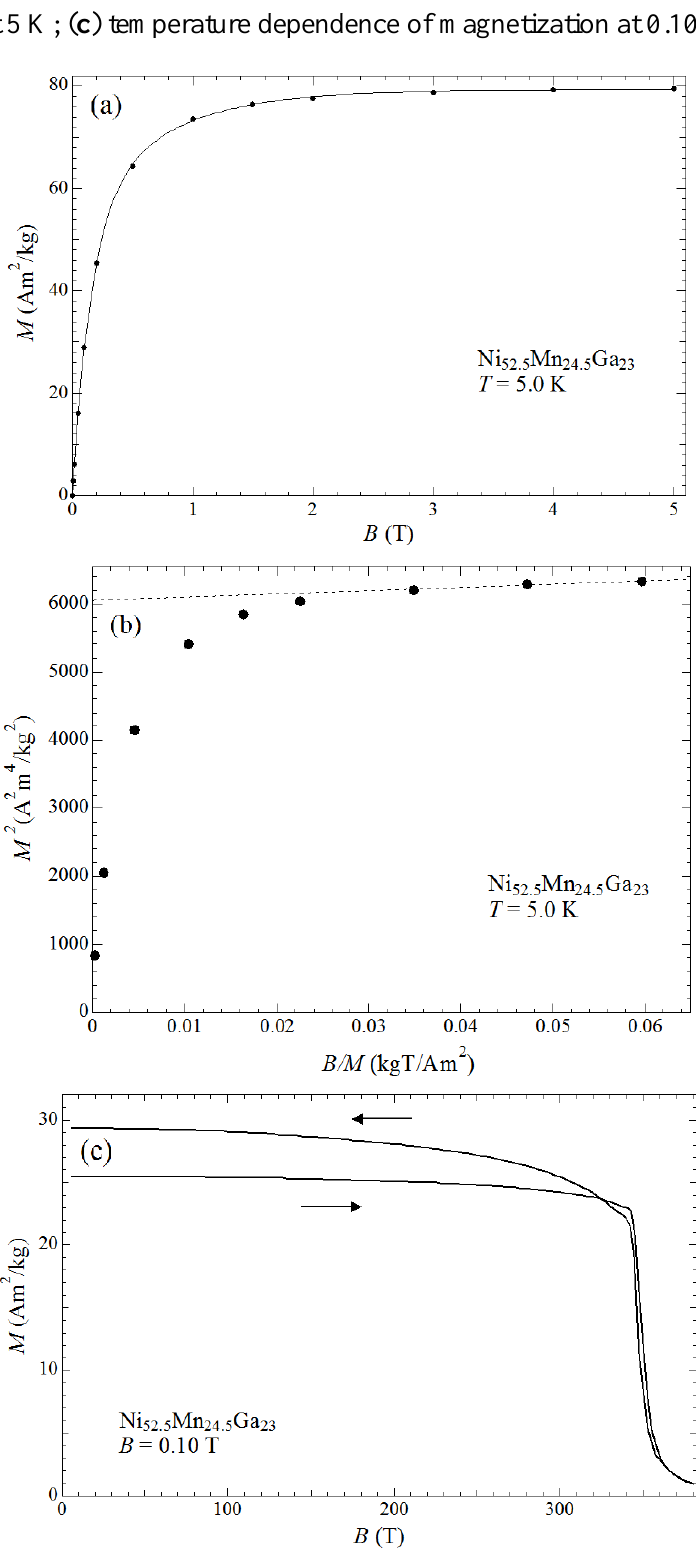
Mn Ga in a static magnetic field; ( b ) Arrott plot of 52.5 24.5 23